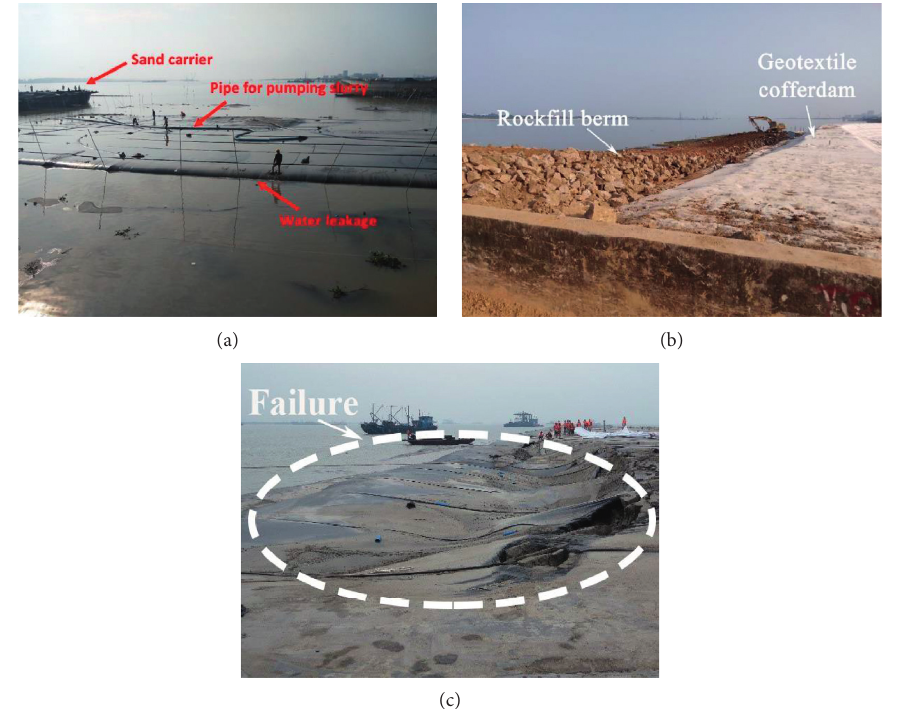
Figure 1: Geotextile mat dike: case of practice. (a) Geotextile mat construction. (b) Dike with rockfill berm. (c) Large geotextile